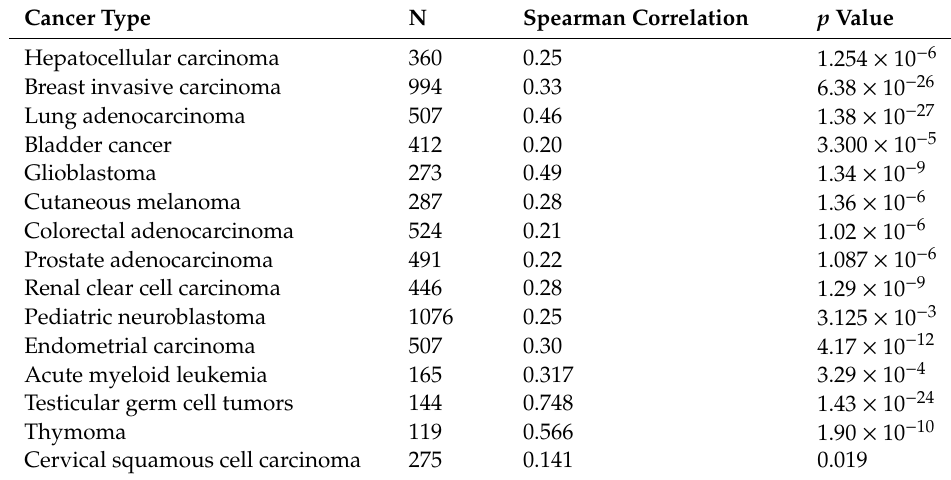
Table 1. The correlation between telomerase reverse transcriptase (TERT) and DNA Methyltransferase 3B (DNMT3B) expression in the Cancer Genome Atlas (TCGA) cancer cohorts. Cancer Type N Spearman Correlation p Value Hepatocellular